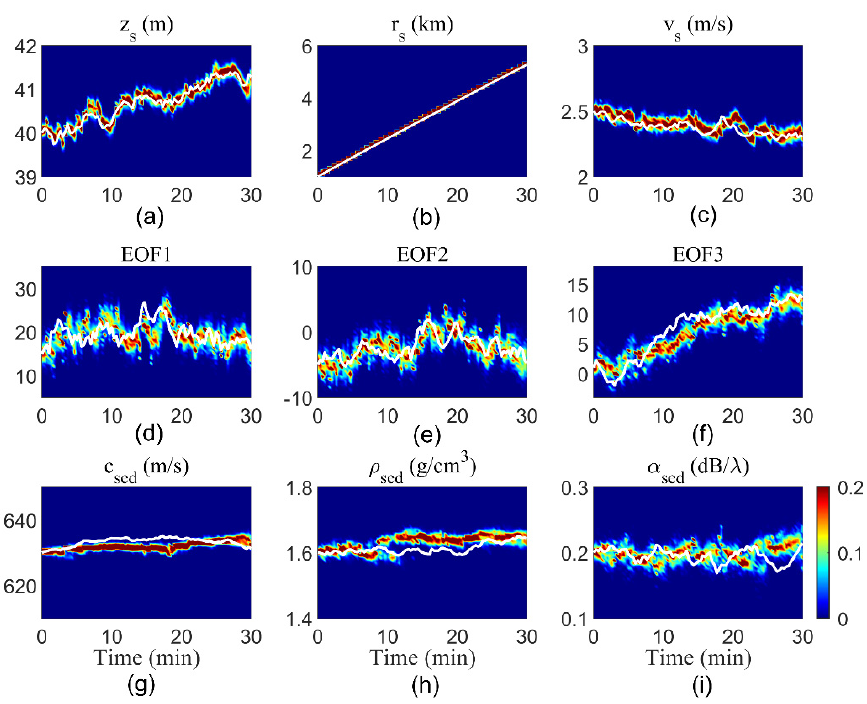
Figure 3. The improved SIR PF tracking results of nine parameters: time-evolving 1-D marginal PPDs for the ( a ) depth, ( b ) range, and ( c ) speed of the source; ( d-f ) three EOFs; and sediment ( g ) sound speed, ( h ) density, and ( i ) attenuation. The solid lines represent the true trajectories.